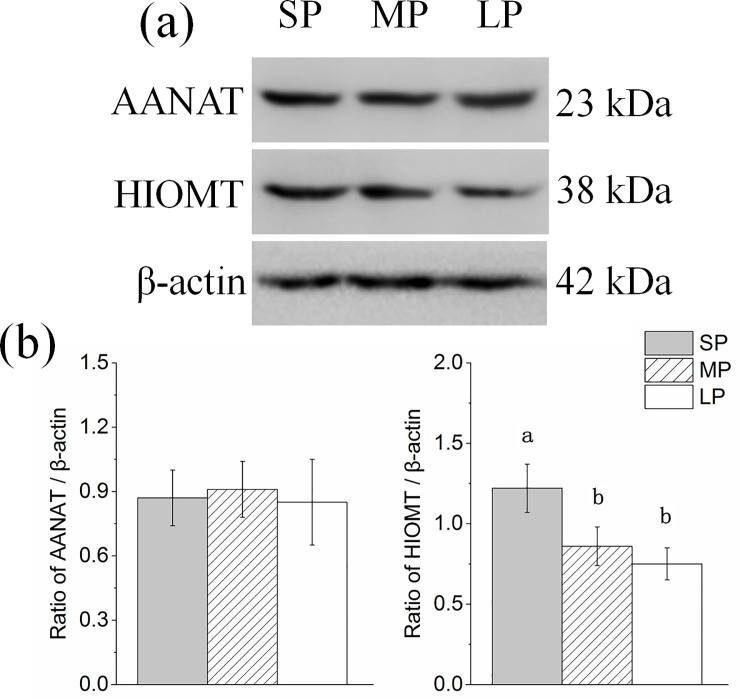
Changes in protein levels of melatonin synthase in HG of hamsters in three different photoperiodic groups.(a) Representative immunoblots of AANAT, HIOMT and β-actin in three different photoperiodic groups. (b) Ratio of AANAT, HIOMT to β-actin in HG of hamsters in three different photoperiodic groups. Values are means ± SD. n = 10. SP, short photoperiod; MP, moderate photoperiod; LP, long photoperiod. Different letters identify statistically significant difference (P < 0.05).